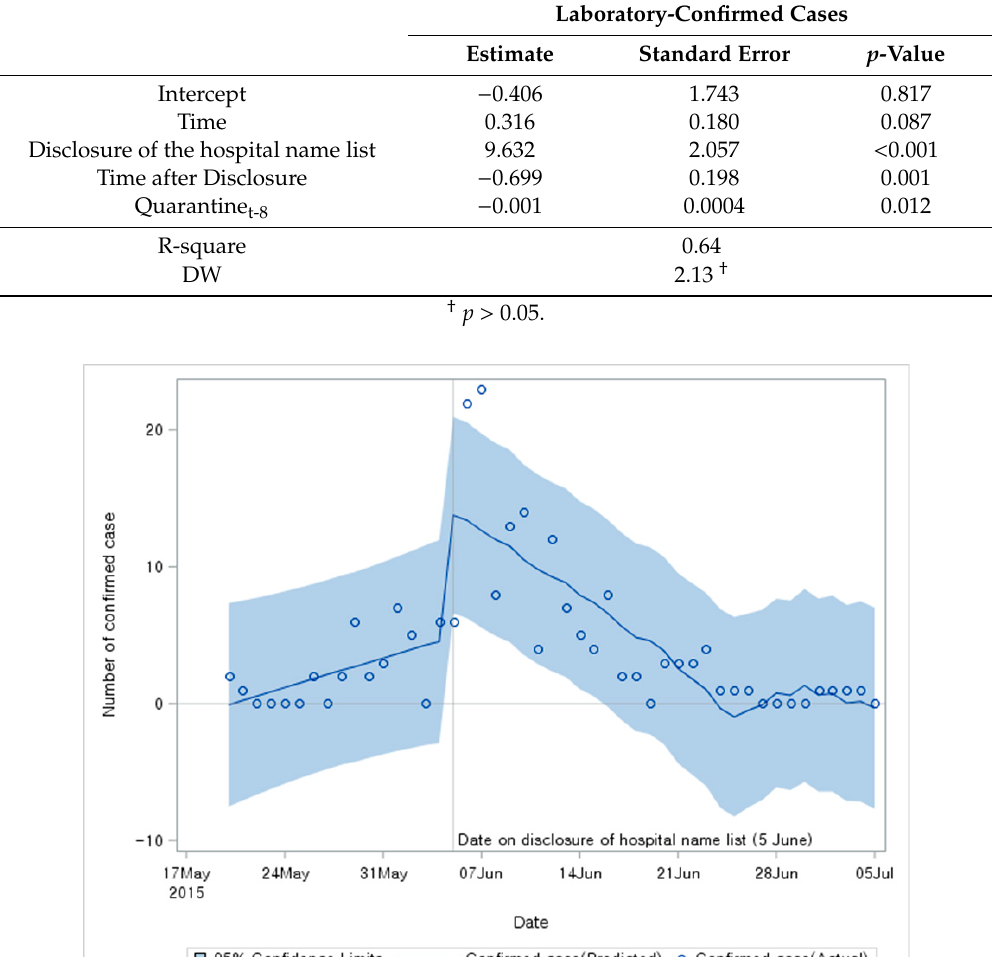
Table 1. E ff ects of disclosure of hospital list.